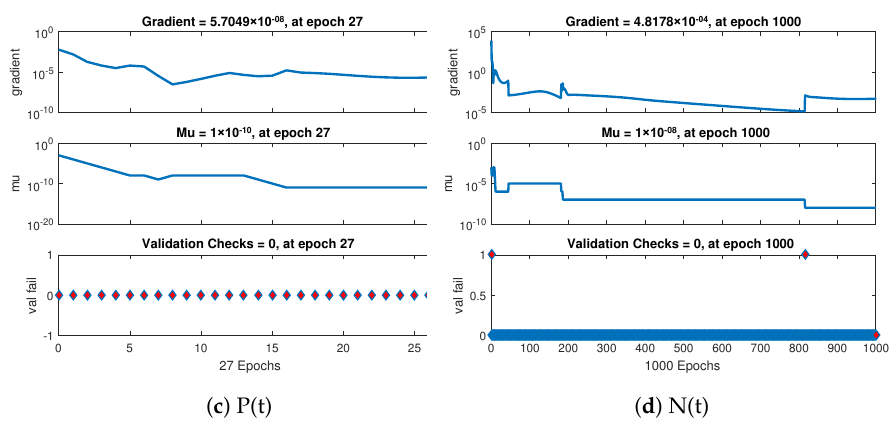
Figure 8. Performance based on validations failure, mu, and gradient of NNs-LMT for case 2.